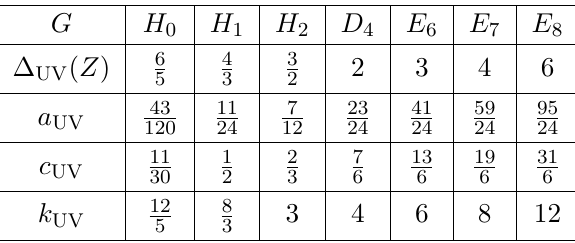
Table 2. Scaling dimensions and anomalies of rank 1 4D N = 2